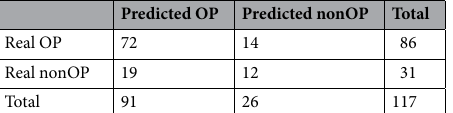
Table 2. Confusion matrix of the external validation. OP